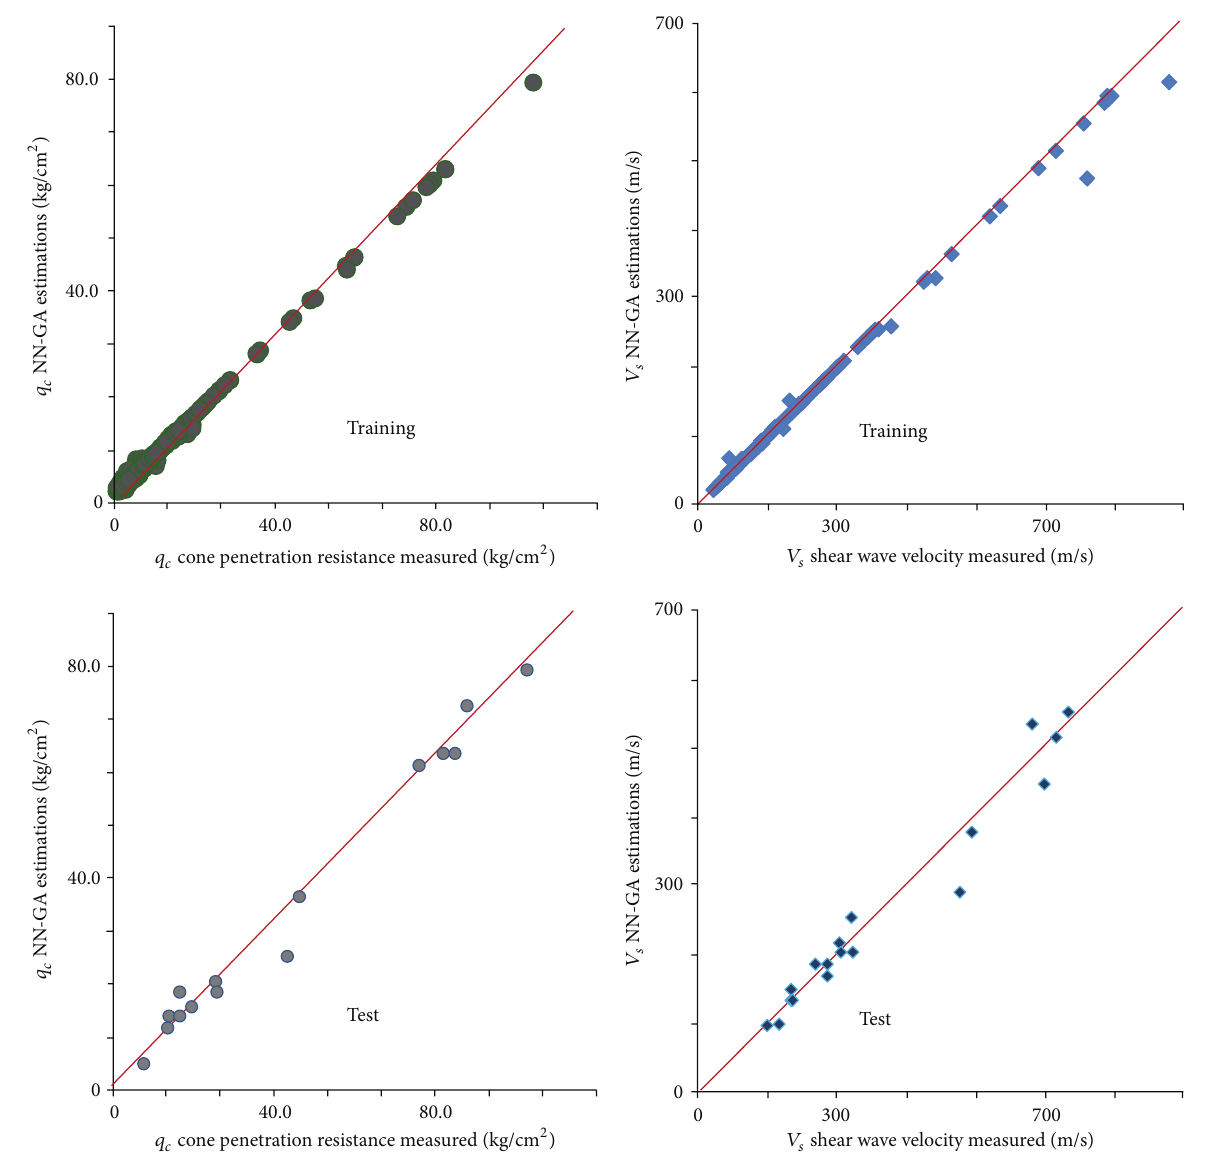
Figure 6: Measured versus evaluated values of 𝑞 𝑐 and 𝑉 𝑠